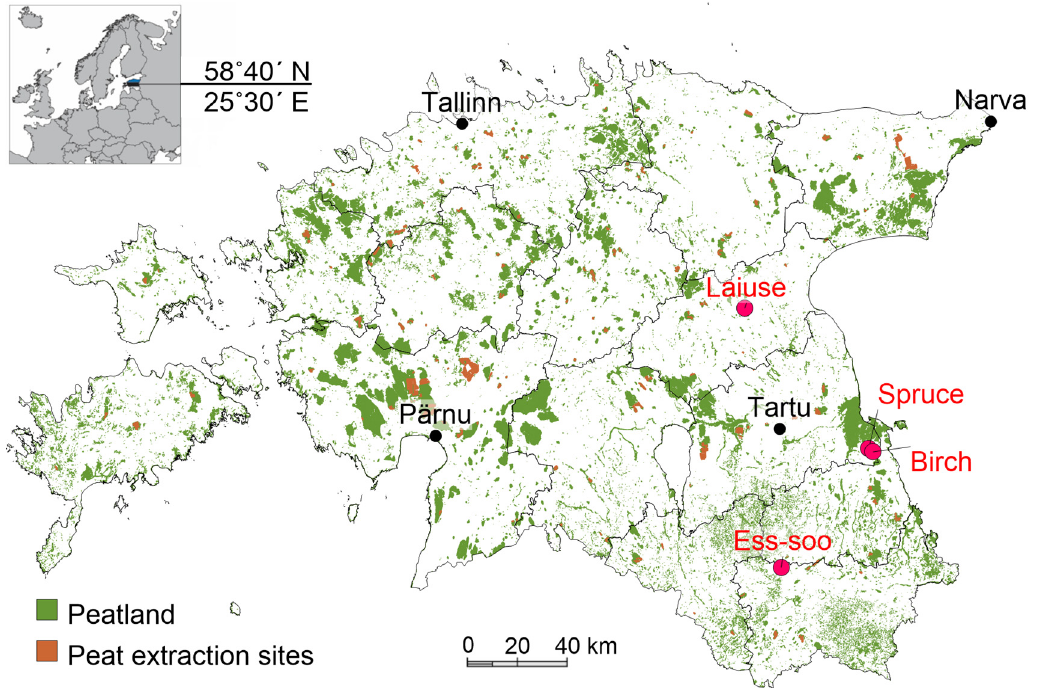
Figure 1. Location of study sites. Laiuse and Ess-soo are abandoned peat extraction areas and birch and spruce drained peatland forests are dominated by Downy birch and Norway spruce, respectively.